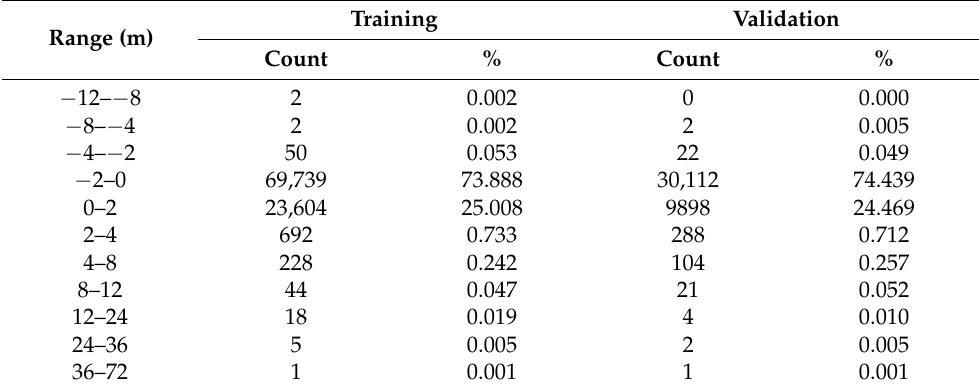
Table 4. Frequency distribution comparison of residual errors between training and validation subsets for the DTB